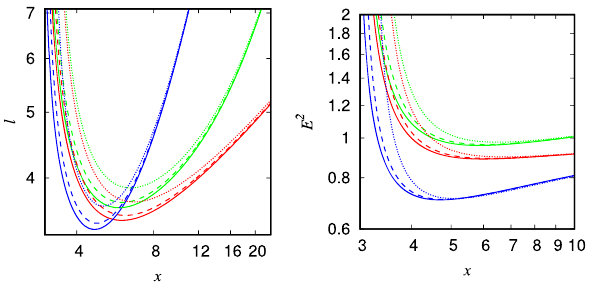
Fig. 6 Radial dependence of l and E 2 with different values of b and ω B . Red, blue and green colors denote respectively -0.01. Solid, dashed and dotted lines denote respectively b = 0, 0.5, 1